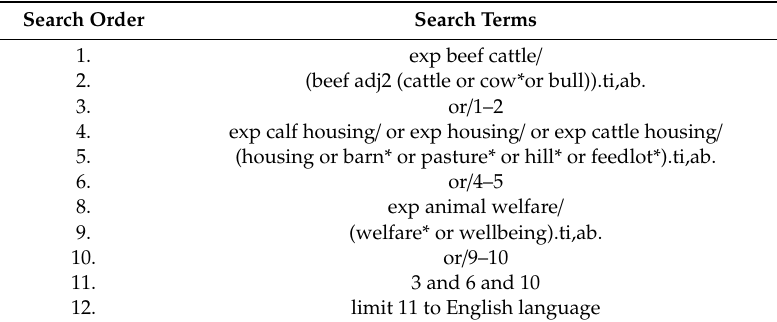
Table 1. CAB Abstracts (Ovid) search